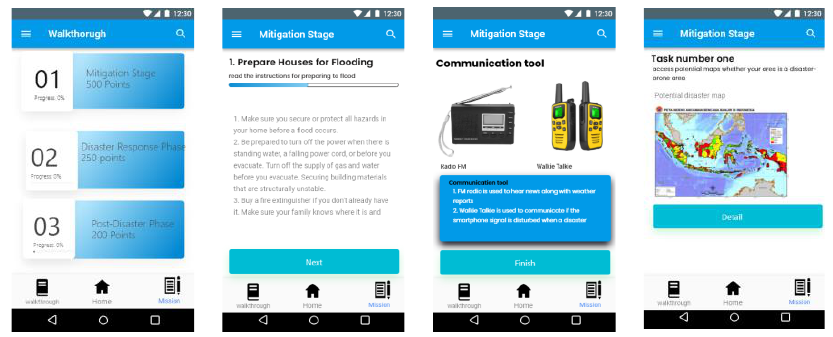
Fig. 3. Walkthrough menu for mitigation